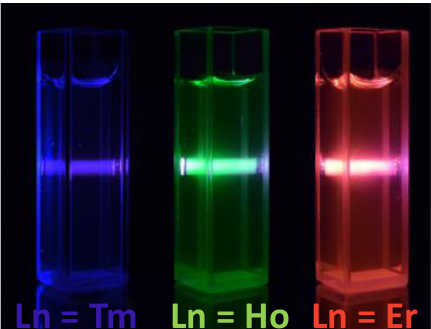
Figure 22. Up-conversion fluorescence images for Gd 2 O 3 :Yb 3+ -Ln 3+ (Ln = Ho, Er or Tm) colloids under excitation at 980 nm, obtained using a digital camera without any filter. Reproduced from [228], with permission from DOVE Press Publisher, 2016. Within the same strategy, co-doped diamagnetic nanocrystals like LaF 3 :Yb 3+ -Ho 3+ were also used. They offer both up-conversion properties and MRI contrast capabilities. Their measured in water r 1 and r 2 reached a value of 0.12 and 28.18 mM − 1 .s − 1 per Ho, at 11.0 T (500 MHz) and 27 ◦ C [229].